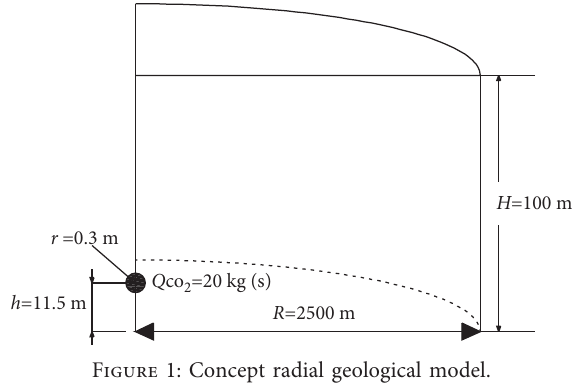
Figure 1: Concept radial geological model.